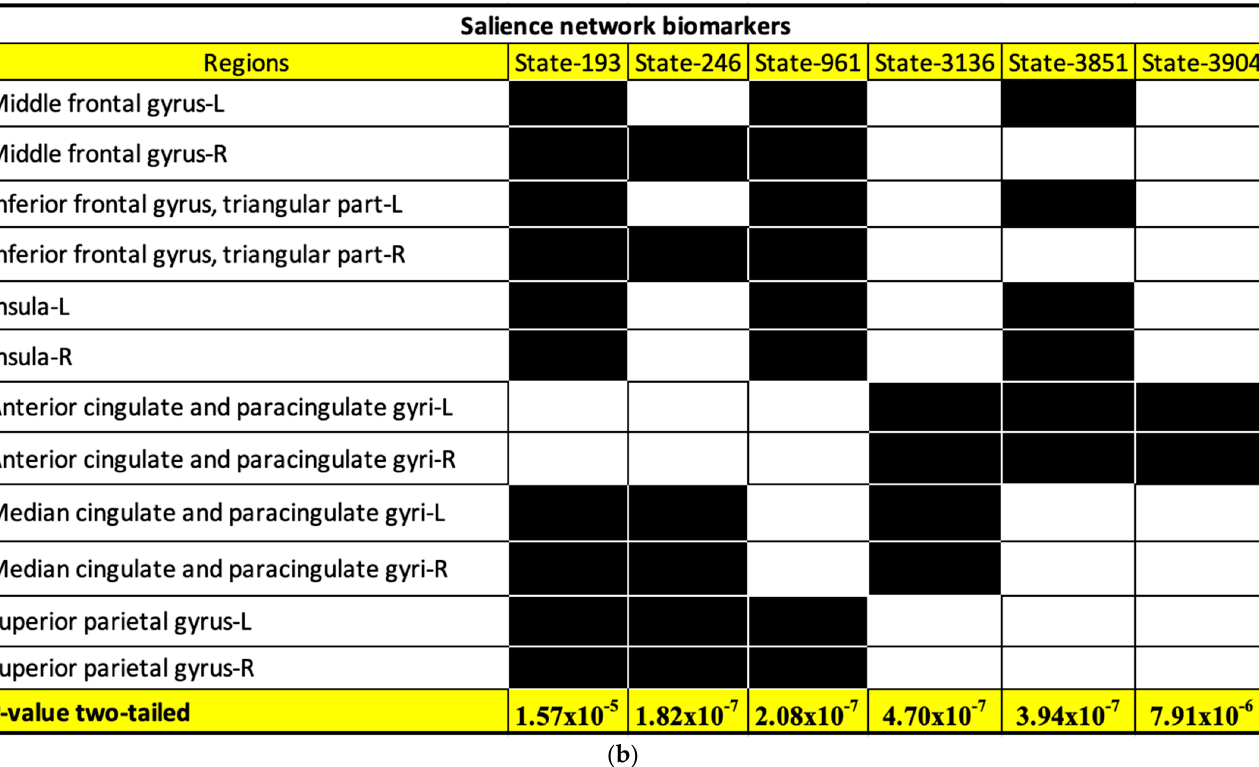
Figure 5. Two − sample t − test was performed on the local minimum states of the SAN whose energy Figure 5. Two–sample t -test was performed on the local minimum states of the SAN whose energy difference was maximum and the states whose p − values satisfy the Bonferroni correction are con- difference was maximum and the states whose p –values satisfy the Bonferroni correction are con- sidered potential connectivity signatures. ( a ) Two − sample t − test results of the connectivity signa- sidered potential connectivity signatures. ( a ) Two–sample t -test results of the connectivity signature ture state for SAN. ( b ) Connectivity signature states definitions for SAN. state for SAN. ( b ) Connectivity signature states definitions for